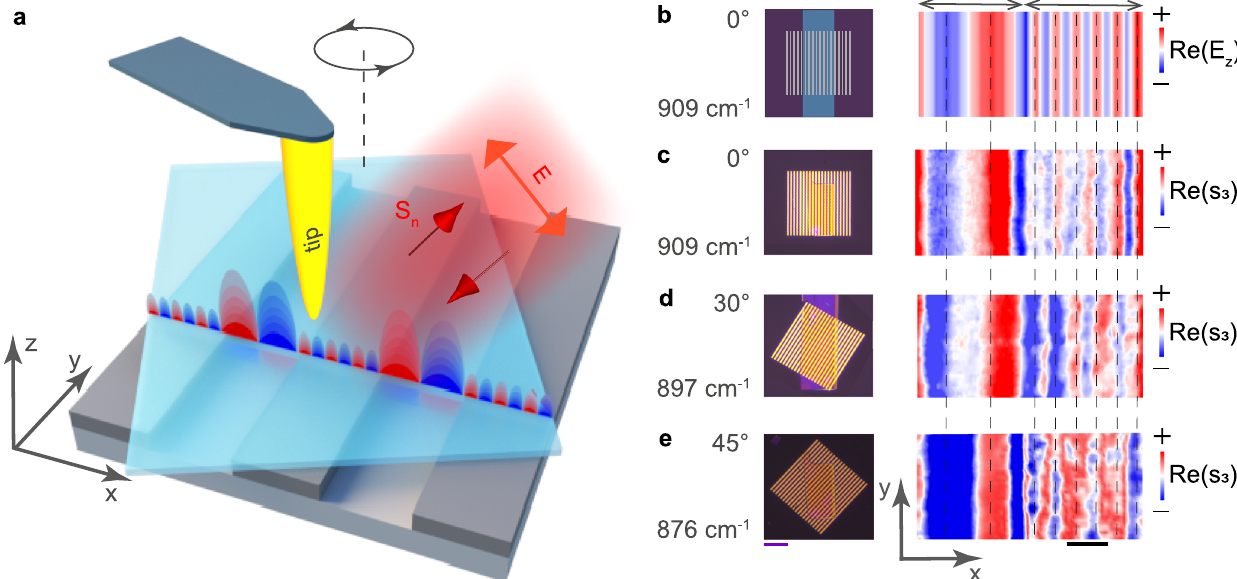
Fig. 3 Near- fi eld measurements of twist-tunable PhP nanoresonators. a Schematic of the near- fi eld measurements by s-SNOM, in which a metal tip is illuminated by p-polarized mid-IR light and both the amplitude and phase of the tip-scattered fi eld are recorded as a function of the tip position. b Simulated fi eld distribution, Re( E z ), in the α -MoO 3 /air and α -MoO 3 /metal regions. c – e Experimental near- fi eld images, Re( s 3 ), of one of the unit cells of the heterostructure for the twist angles φ ¼ 0 ; 30 ; and 45°, respectively, taken at the resonant frequencies. The fl ake thickness is 110 nm since we use the same fl ake in all the experiments. Purple scale bar: 20 μ m and black scale bar: 0.5 μ